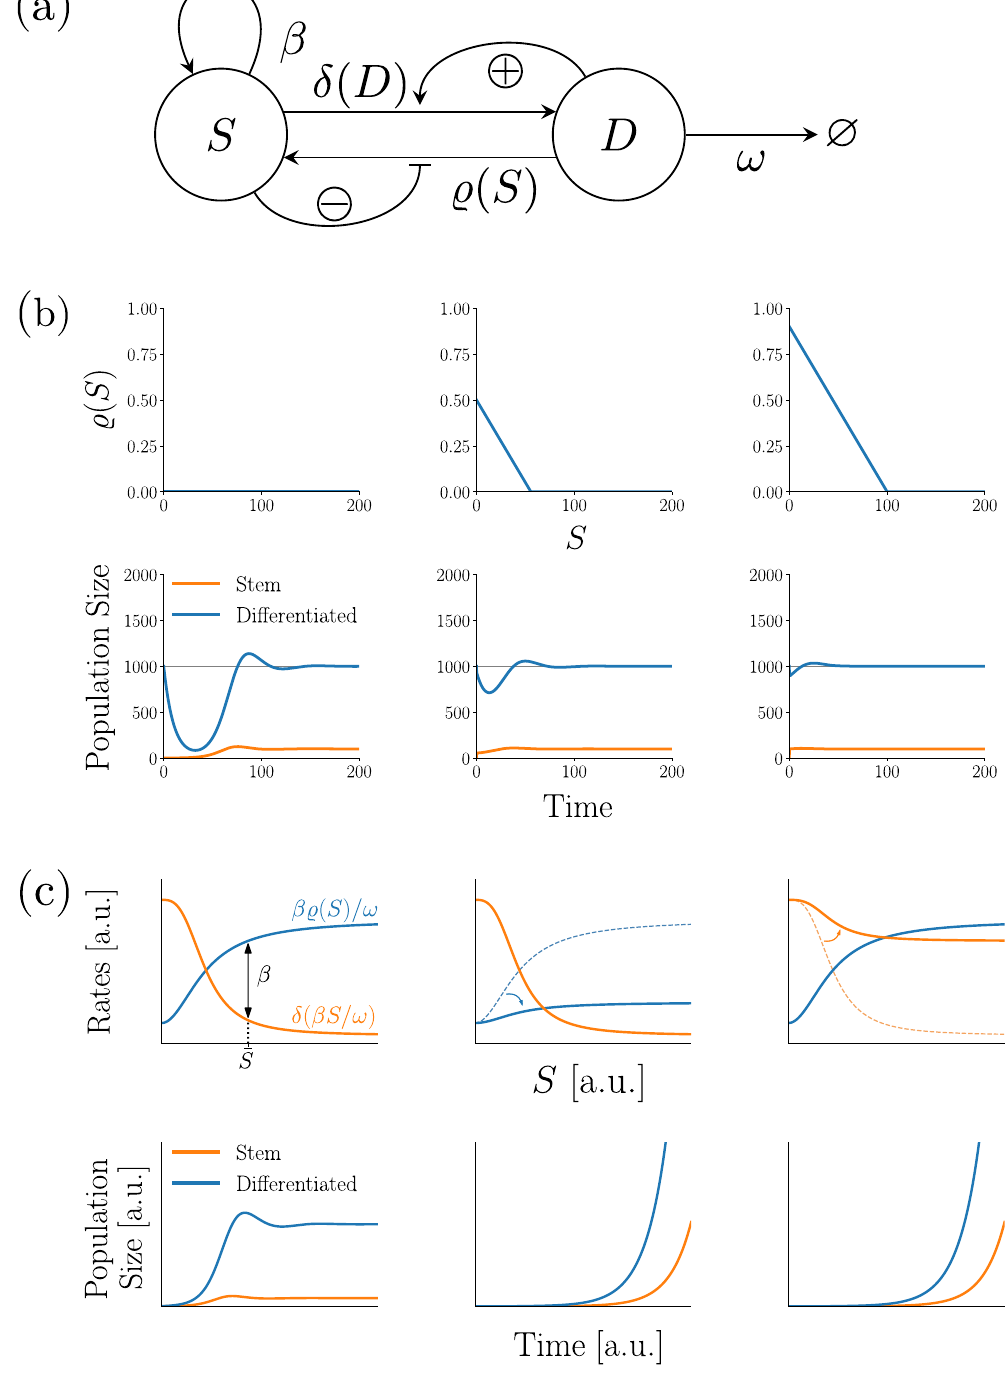
Figure 4. The colon epithelium model with dedifferentiation and its most important properties. (a) Schematic sketch of the model. (b) Exemplary numerical simulations of the system with piecewise linear differentiation rate function δ and different dedifferentiation rate functions ̺ : no dedifferentiation (first column), linear dedifferentiation with ̺ 0 = 0.5, ̺ slope = − 0.01 (second column) and a faster linear dedifferentiation ̺ 0 = 0.9, ̺ slope = − 0.01 (third column). System parameters are β = 1, δ 0 = 0.9, δ slope = 10 − 4 , ω = 0.1 . Note how adding dedifferentiation, as well as increasing the higher maximum dedifferentiation rate ̺ 0 makes the system recover faster and with smaller oscillations after removing stem cells. (c) Adding dedifferentiation opens up a second way the system can lose homeostatic stability. First column shows the case of homeostasis. Equilibrium stem cell pool size ¯ S is given by solving β̺( ¯ S )/ω − δ(β ¯ S /ω) = β . Second column: Sufficient decrease of differentiation rate destroys the non-trivial steady state and unbounded growth occurs. Third column: Sufficient increase of dedifferentiation rate has the same